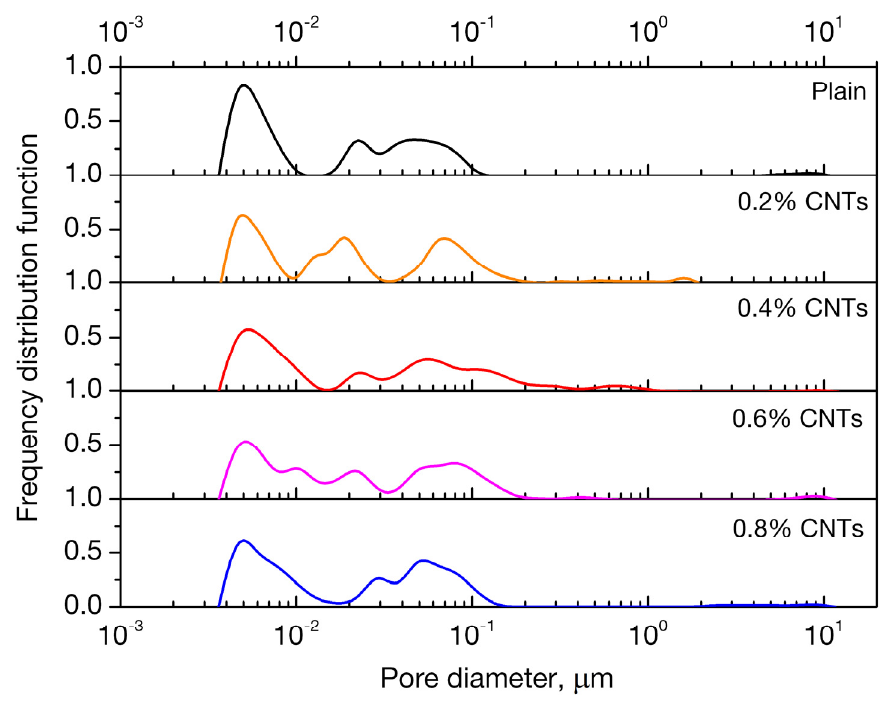
Figure 9. Pore size distributions of nano-modified mortars.